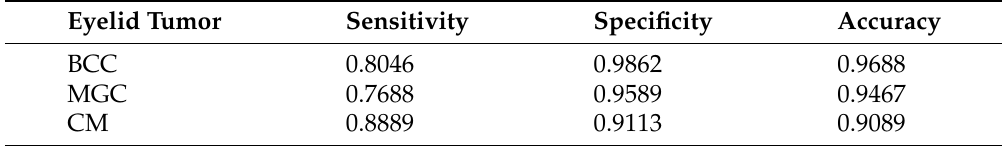
Table 6. Overall average classification